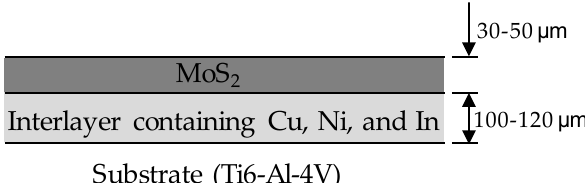
Figure 9. A conventional thermally sprayed double layer coating for an aerospace component [25,26].